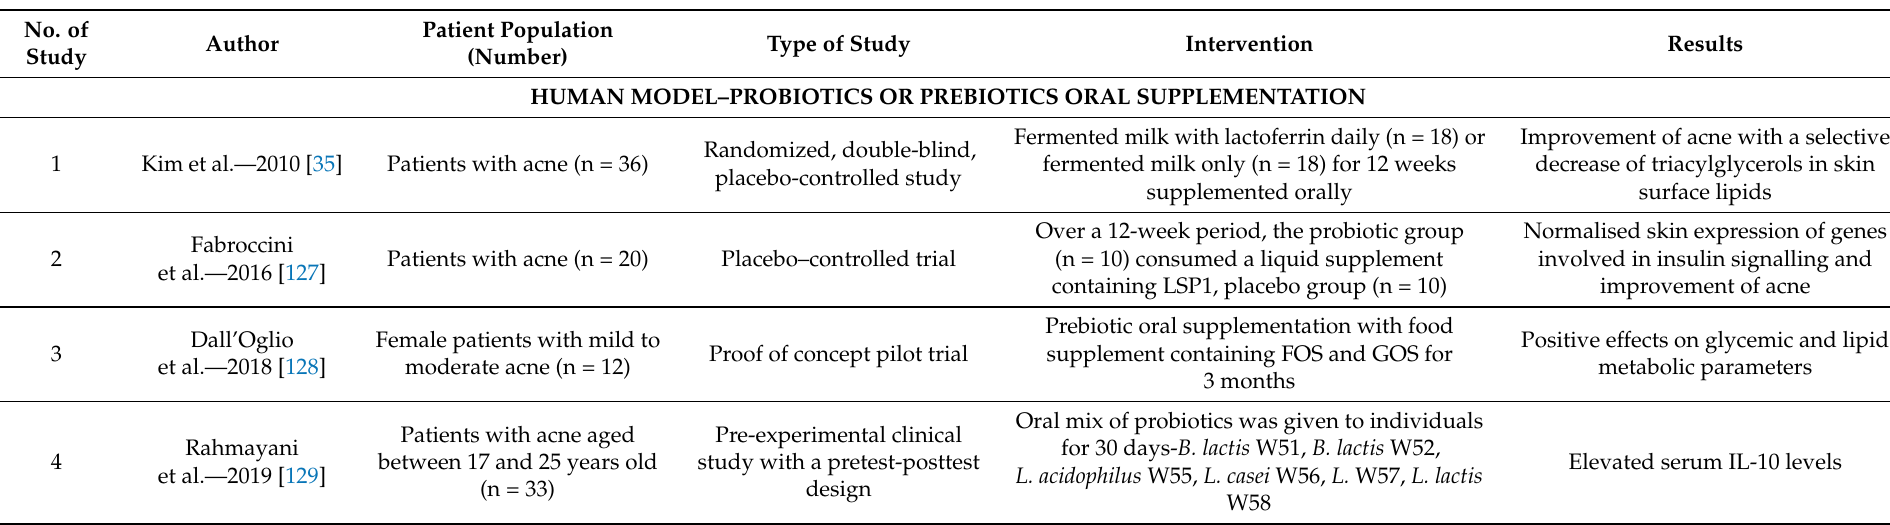
Table 10. Pre- and probiotic treatment of acne in humans, animal models and in vitro